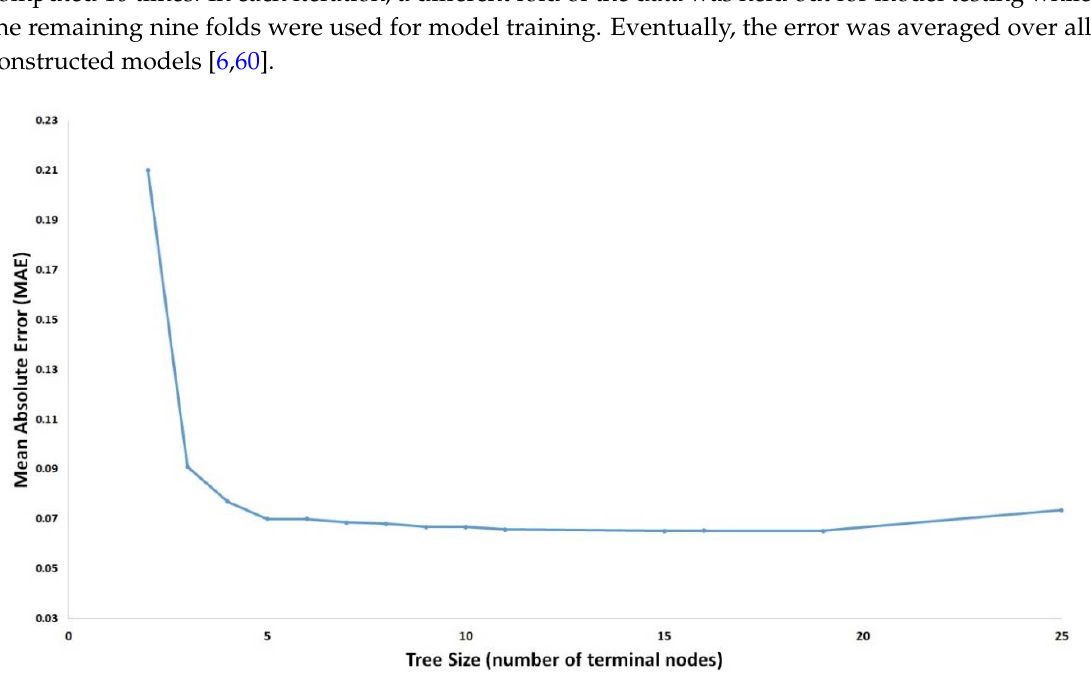
Figure 8. Comparison of various pruned regression ‐ trees, based on the mean absolute error (MAE) calculated by a 10 ‐ fold cross ‐ validation